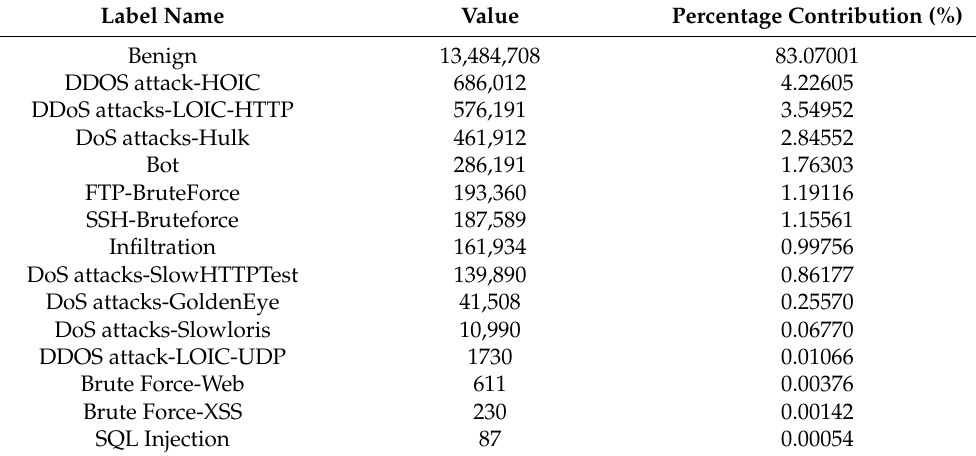
Table 3. Distribution of stream records in CICIDS2018